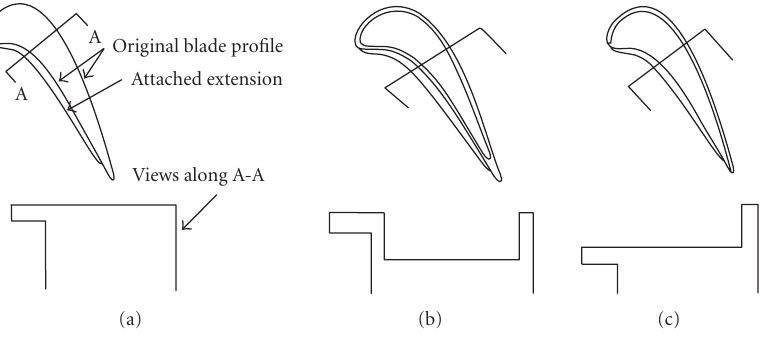
Figure 1: Schematics of (a) flat tip with winglet, (b) squealer tip with winglet, and (c) suction-side squealer with winglet.